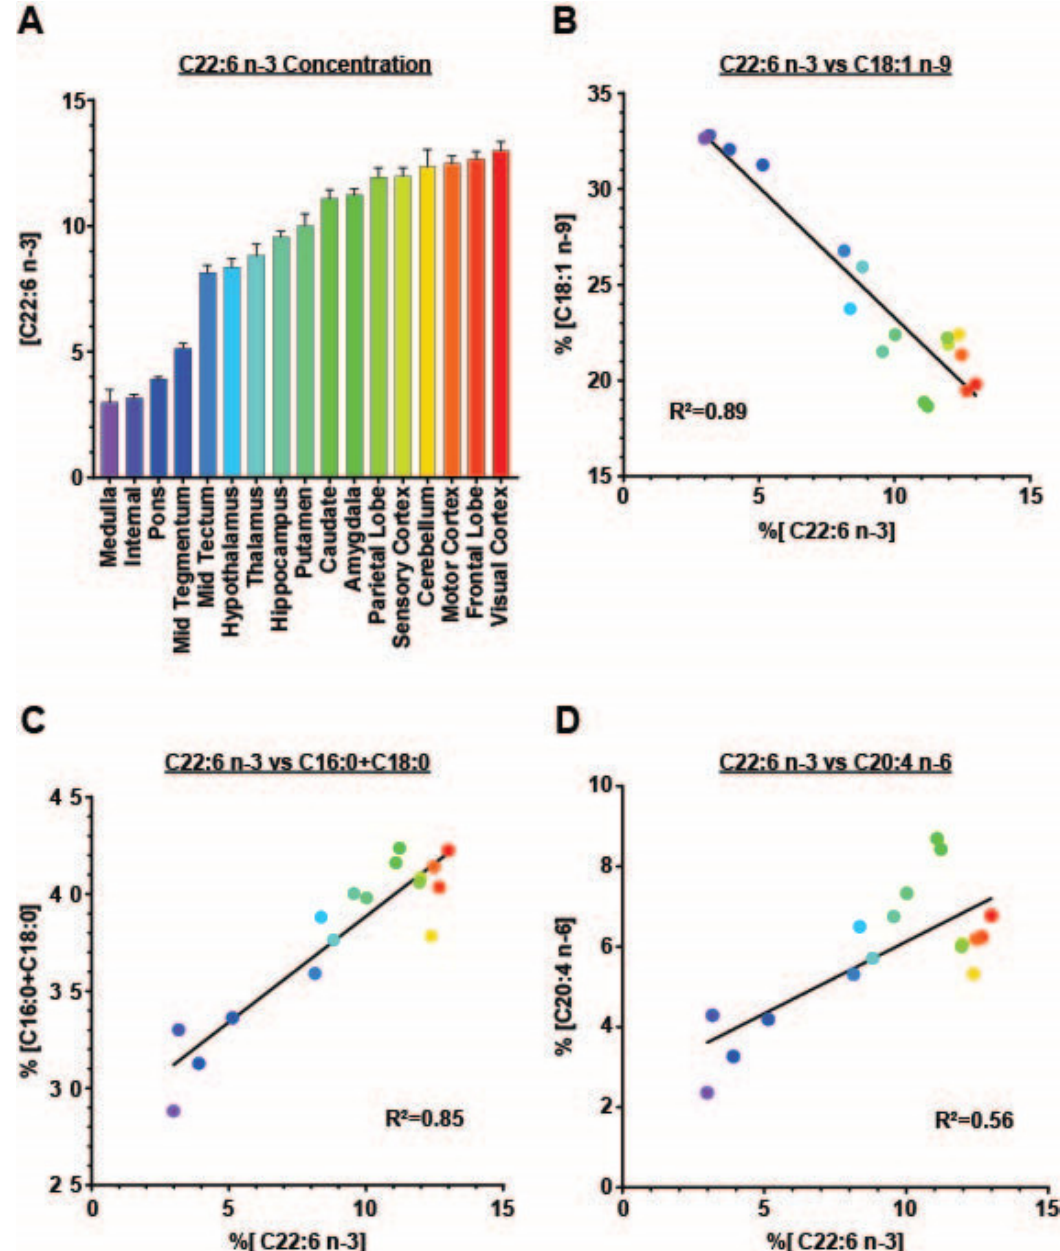
Figure 2. ( A ) Average concentrations of DHA (C22:6 n3) across the brain regions, and the correlation between DHA (C22:6 n 3) and 18:1 n9 ( B ), C16:0 + C18:0 ( C ), and arachidonic acid (C20:4 n6) ( D ).